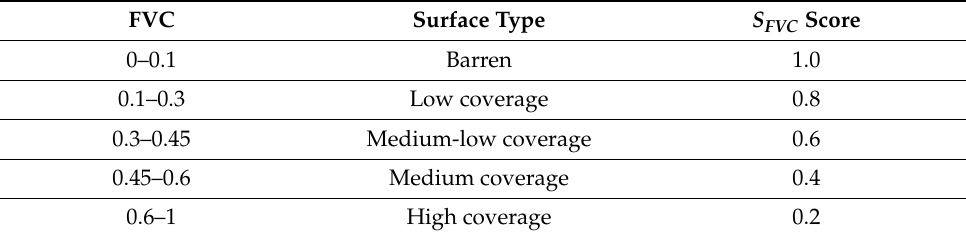
Table 1. The assessment rules for the fractional vegetation cover